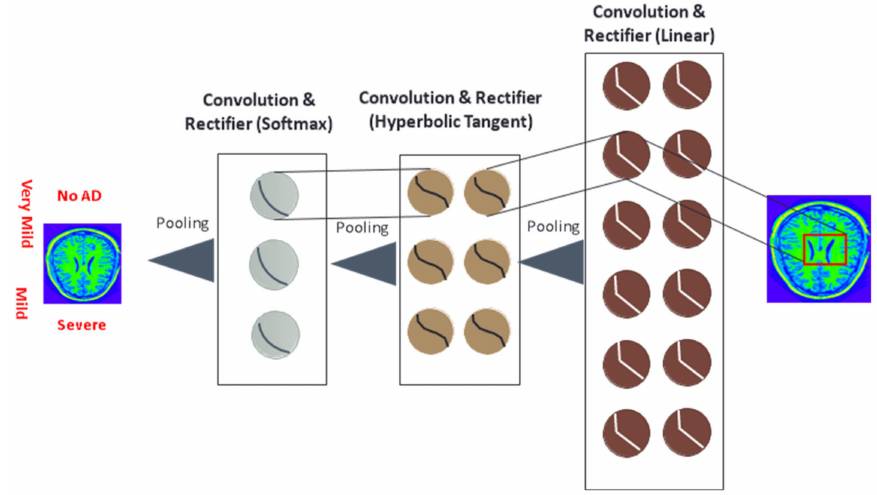
Figure 3. Example convolutional neural network for AD classification (read from right to